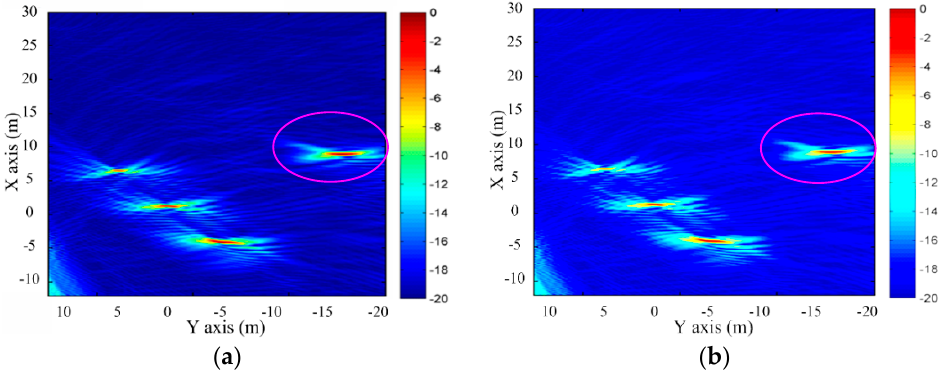
Figure 18. Imaging results of the measured data obtained by the different algorithms. ( a ) Bistatic DTAD; ( b ) Proposed ETDA.